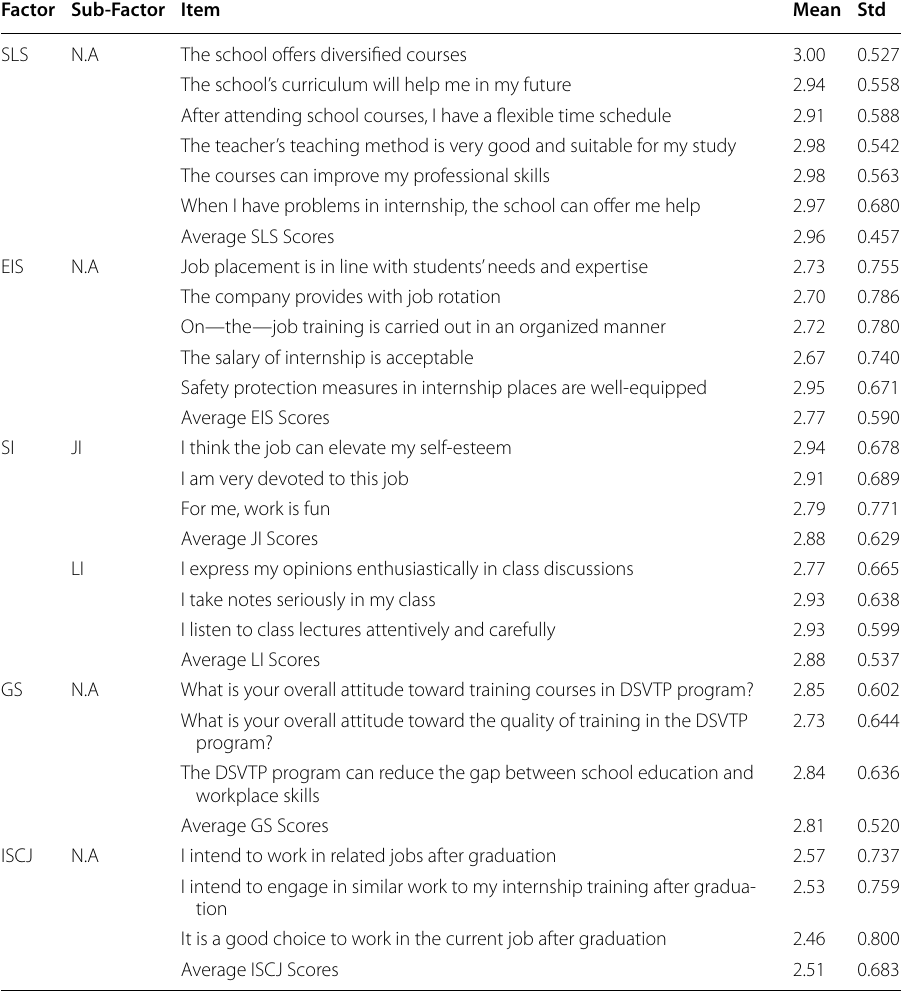
Table 8 Scores for each factor Factor Sub‑Factor Item Mean Std